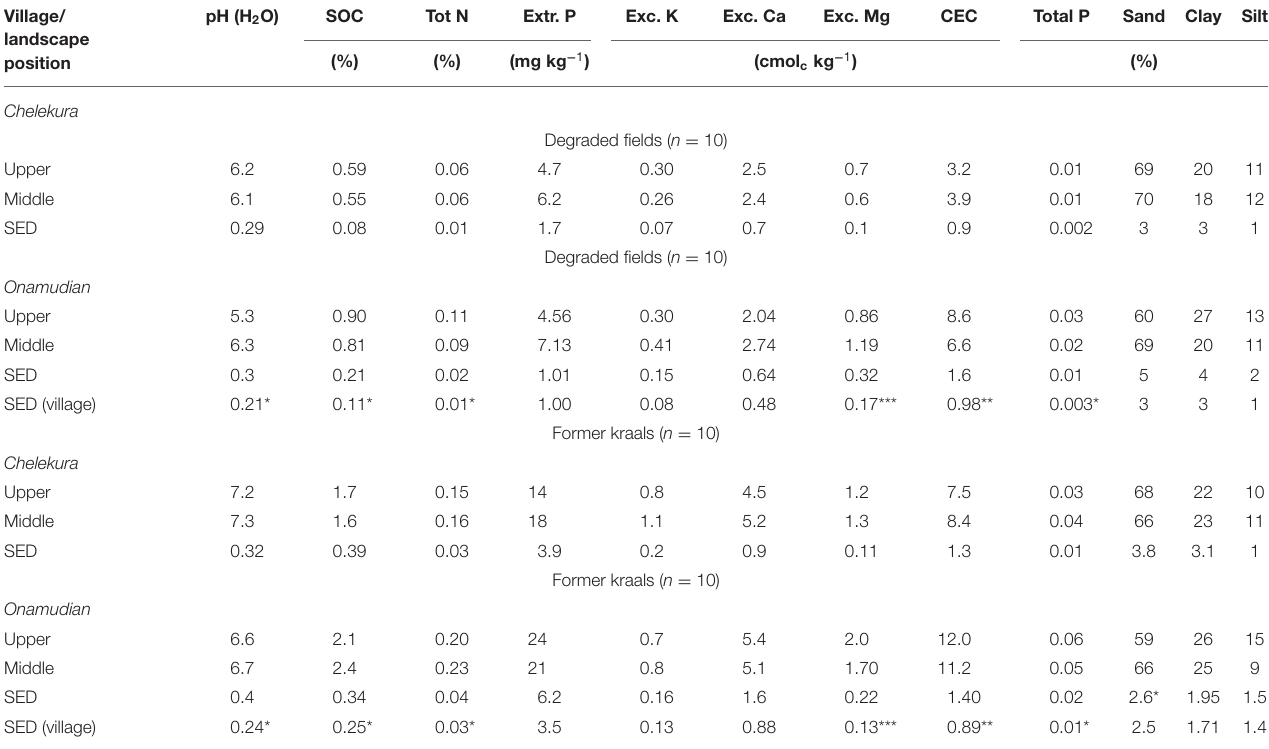
TABLE 1 | Initial soil properties of degraded fields compared with poor fields and former kraals used for experimentation by landscape positions in the study villages. Village/ pH (H 2 O) landscape position